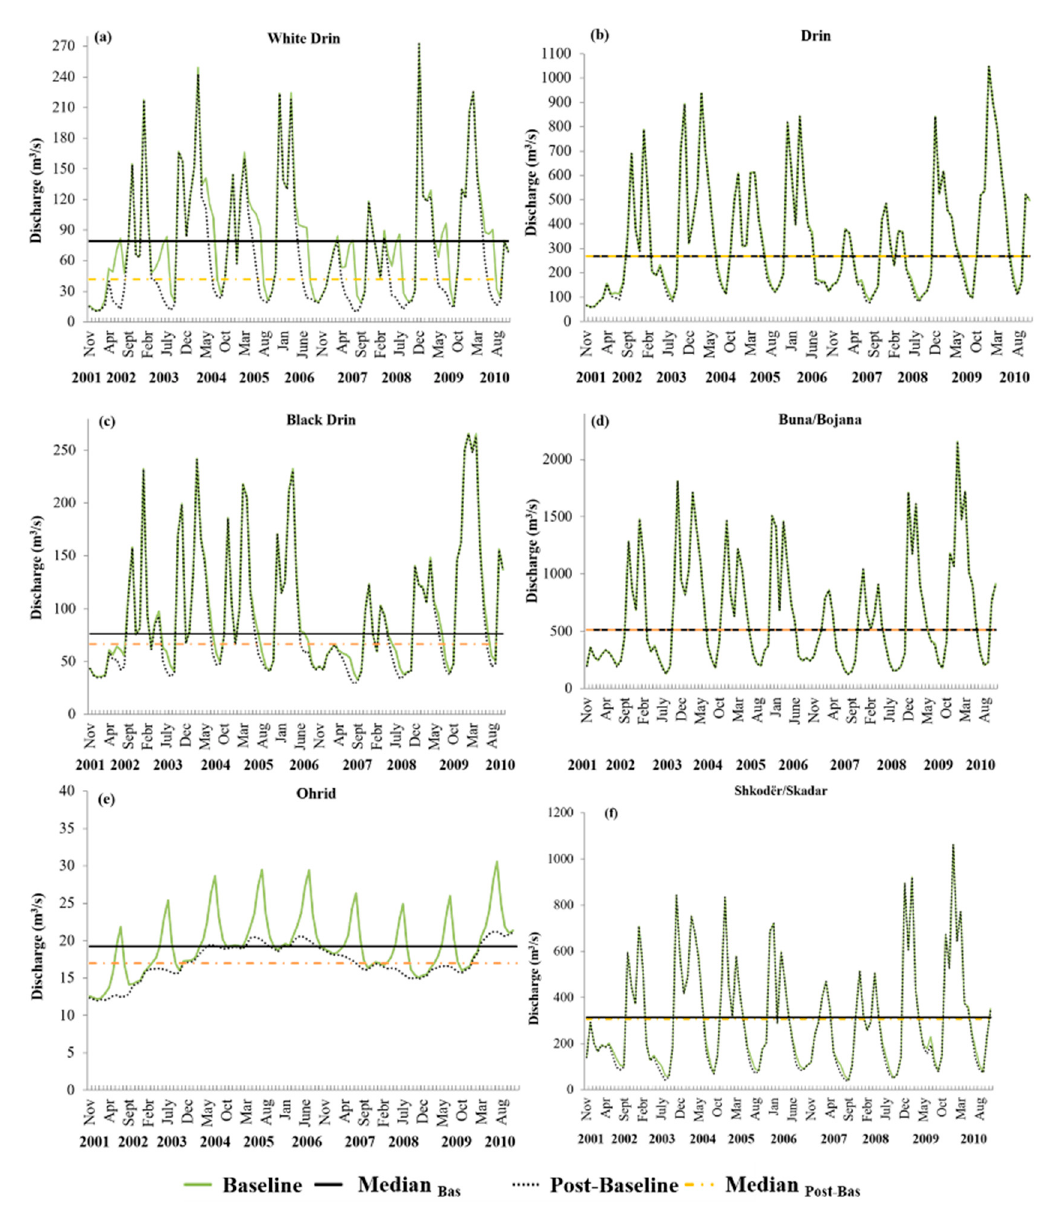
Figure 3. Baseline, post − baseline streamflow, and additional median values for six subbasins (( a ); White Drin, ( b ); Drin, ( c ); Black Drin, ( d ); Buna/Bojana, ( e ); Ohrid, and ( f ); Shkodër/Skadar) of the Drin Basin.